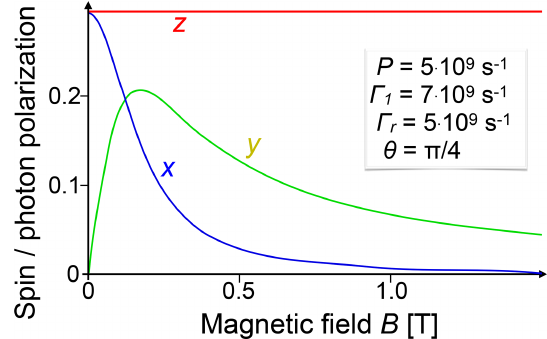
Figure 8. Polarization of the emitted photons as a function of the magnetic field B applied along the z axis. The laser is incident in the x – z plane, at an angle of 45 ◦ from the magnetic field. The remaining parameters are shown in the